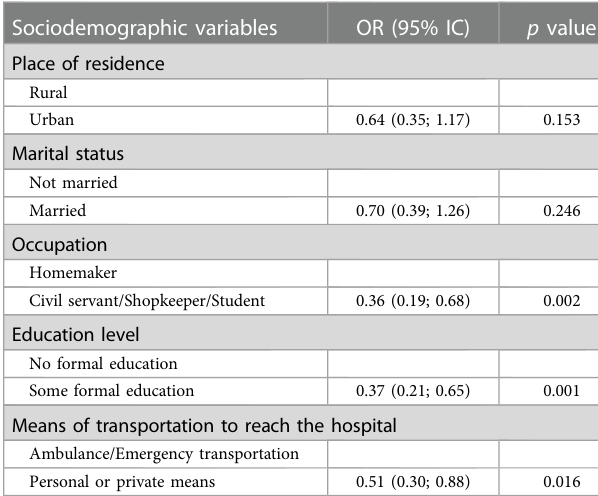
TABLE 2 Sociodemographic factors associated with intrapartum stillbirth with logistic regression. Sociodemographic variables